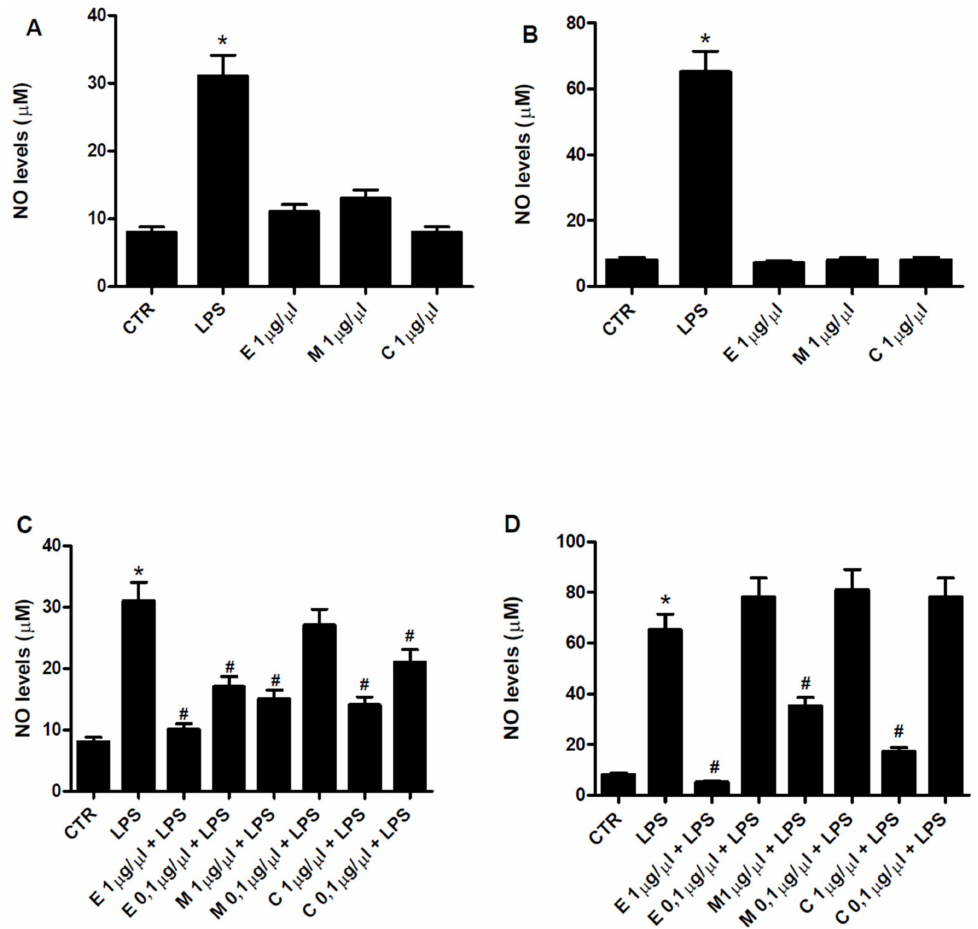
Figure 2. NO inhibition by 40% ethanol plant extracts. Effect of Epilobium parviflorum , Melilotus officinalis, and Cardiospermum halicacabum 1 µ g/ µ L on NO levels in RAW 264.7 macrophage ( A ) and N9 microglial cells ( B ). Effect of Epilobium parviflorum , Melilotus officinalis and Cardiospermum halicacabum 1 µ g/ µ L and 0.1 µ g/ µ L on NO production in LPS(1 µ g/mL)-treated RAW 264.7 macrophage ( C ) and N9 microglial cells ( D ). Bars represent mean ± SEM. * p < 0.05 vs. control; # p < 0.05 vs.